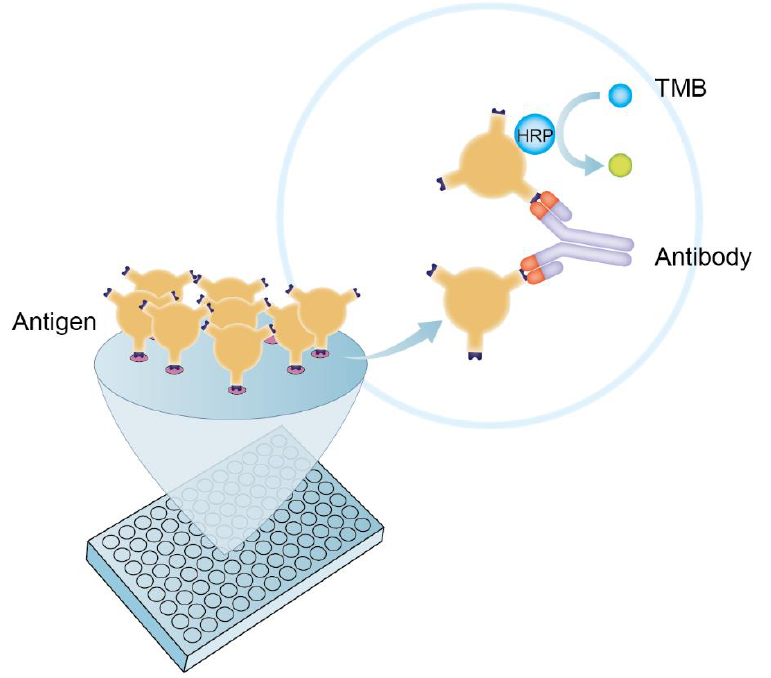
Figure 1. Schematic diagram of DAgS-ELISA Principle. TMB: 3,3,5,5-tetramethylbenzidine; HRP: horseradish peroxidase.